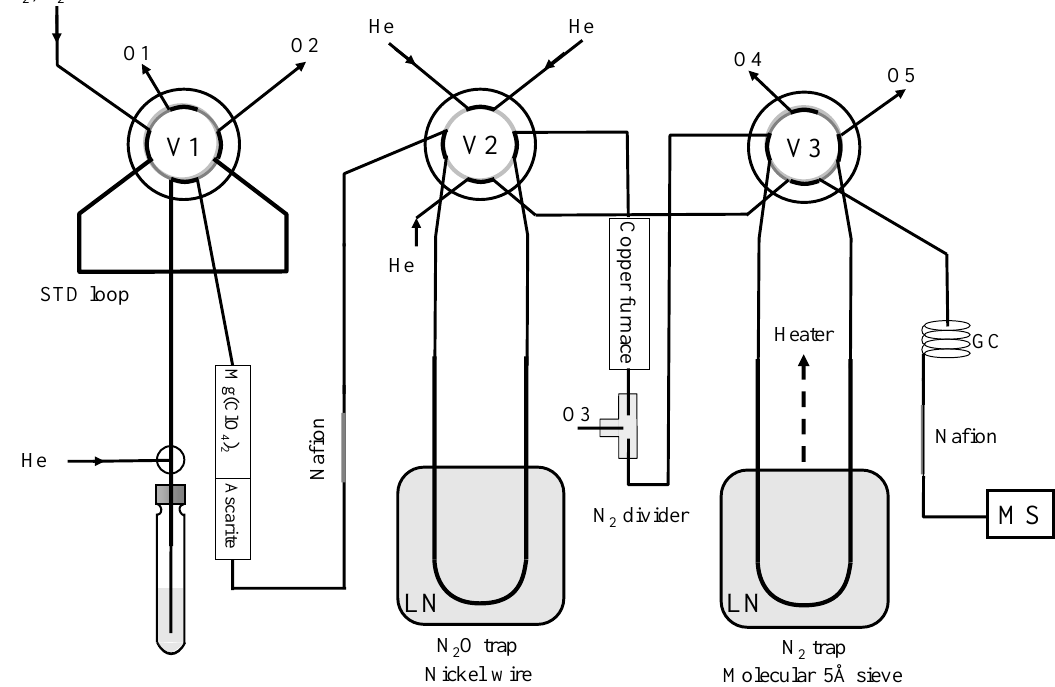
Fig. 2. Schematic diagram of preconcentration system at sample loading phase: GC, gas chromatogram column (ConFlow); He, helium; LN, liquid nitrogen; MS, mass spectrometer; O1–5, outlets to atmosphere; STD, standard gas; and V1–3, automated control valves. Please refer Figure 2. Schematic diagram of pre-concentration system at sample loading phase: 908 to text for GC, gas chromatogram column (ConFlow); He, helium; LN, liquid nitrogen; MS, 909 mass spectrometer; O1-5, outlets to atmosphere; STD, standard gas; V1-3, automated 910 control valves. Please refer to text for details. 911